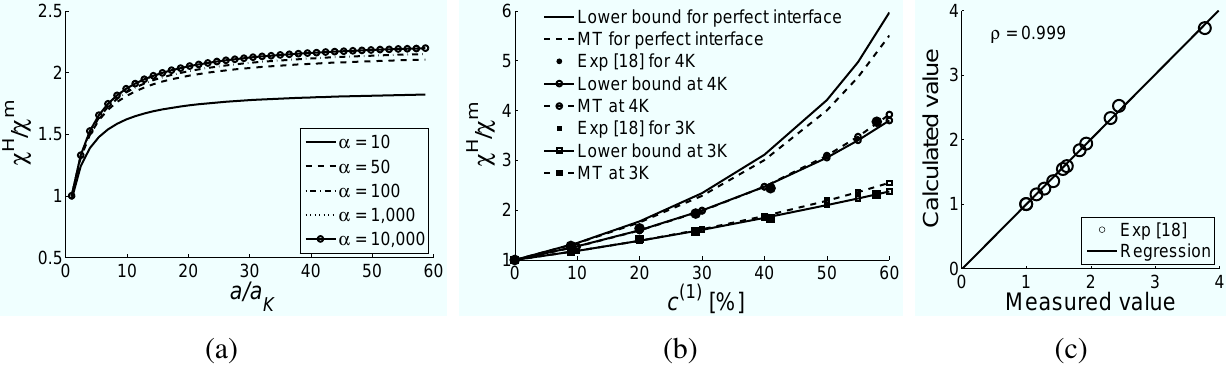
Figure 4. Evolution of the normalized effective thermal conductivity χ H /χ m as a function of ( a ) phase contrast α and relative particle radius a/a fraction c (1) of copper particles, ( c ) correlation of measured and calculated values; ρ is the correlation